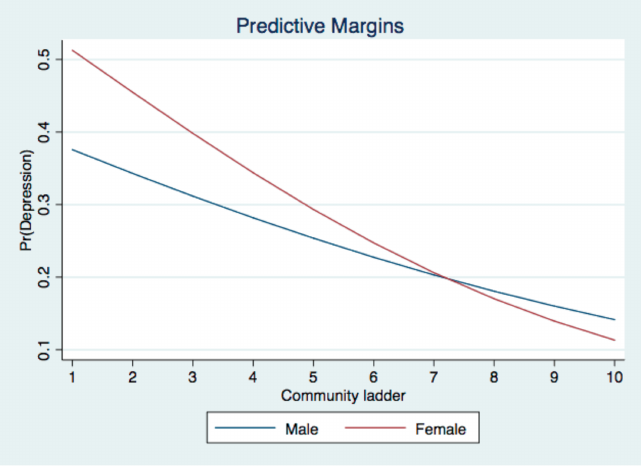
Figure 1. Slopes for men and women. Table 4. Interactive effects between subjective social status and area deprivation in men and